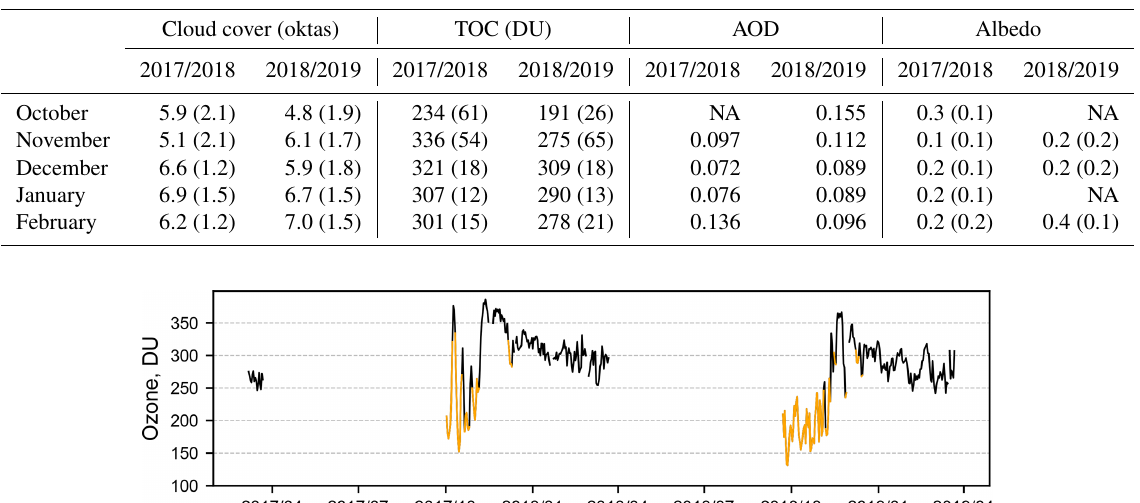
Table 3. Monthly-average total cloud cover (oktas), TOC (DU), AOD at 550nm and albedo with SD in the parentheses for 5 months in the seasons 2017/2018 and 2018/2019. “NA” denotes that data are not available. Cloud cover (oktas)